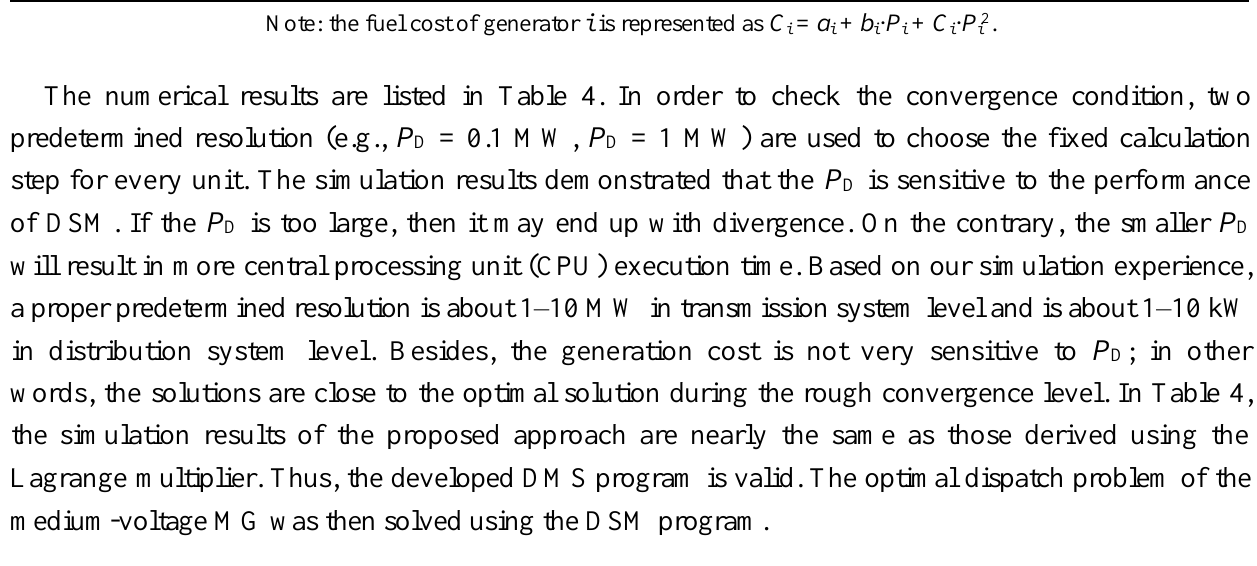
Table 4. Comparison of the simulation results of the Lagrange multiplier method and the DSM for the economic dispatch of the IEEE test systems. CPU: central processing